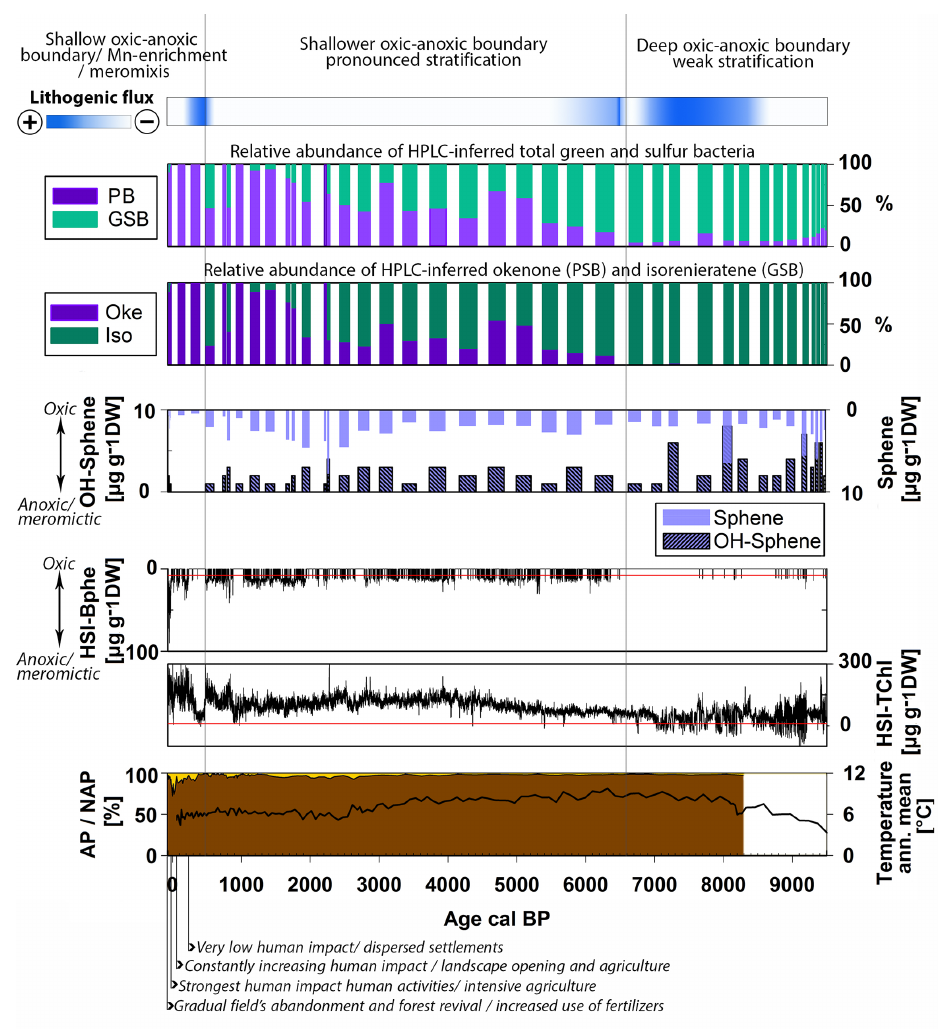
Figure 6. Holocene summary of the relative abundance of purple bacteria (sum of PSB and PnSB) and GSB, Chromatium (okenone, PSB) and Chlorobium (isorenieratene, GSB), the content of spheroidene and spheroidenone pigments produced by R. sphaeroides (PnSB), and the high-resolution calibrated HSI- T Chl and HSI-Bphe concentrations. Top: indication of lithogenic flux and general evolution of the chemo- cline. Bottom: AP / NAP percentages (Kinder et al., 2019; Marcisz et al., 2020) with archeological evidence of human impact and the annual mean temperature variability (Heikkilä and Seppä,